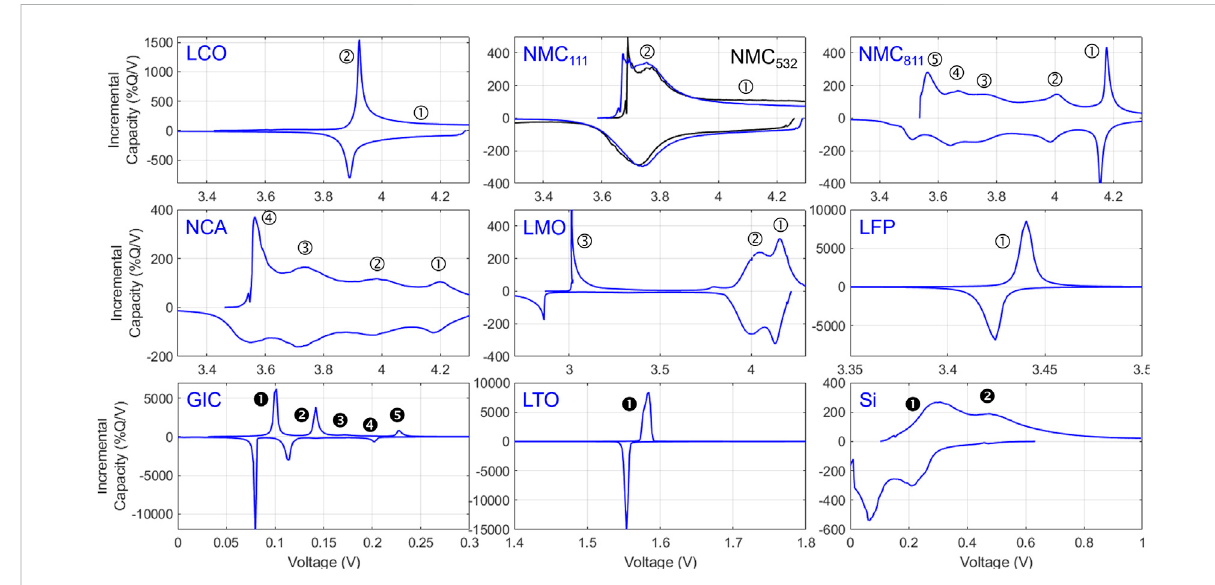
FIGURE 2 Exemplary C/25 electrochemical behavior for all the material used in this